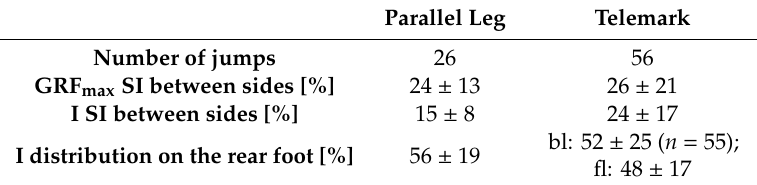
Table 2. Symmetry index (SI) of the normal GRF max and impulse (I), and I distribution on the rear part of the foot during parallel leg and telemark landing (for the front (fl) and back (bl) positioned leg).